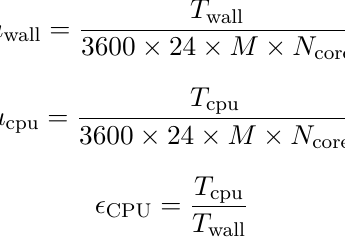
Table 1. Local performance test between host machine and Singularity